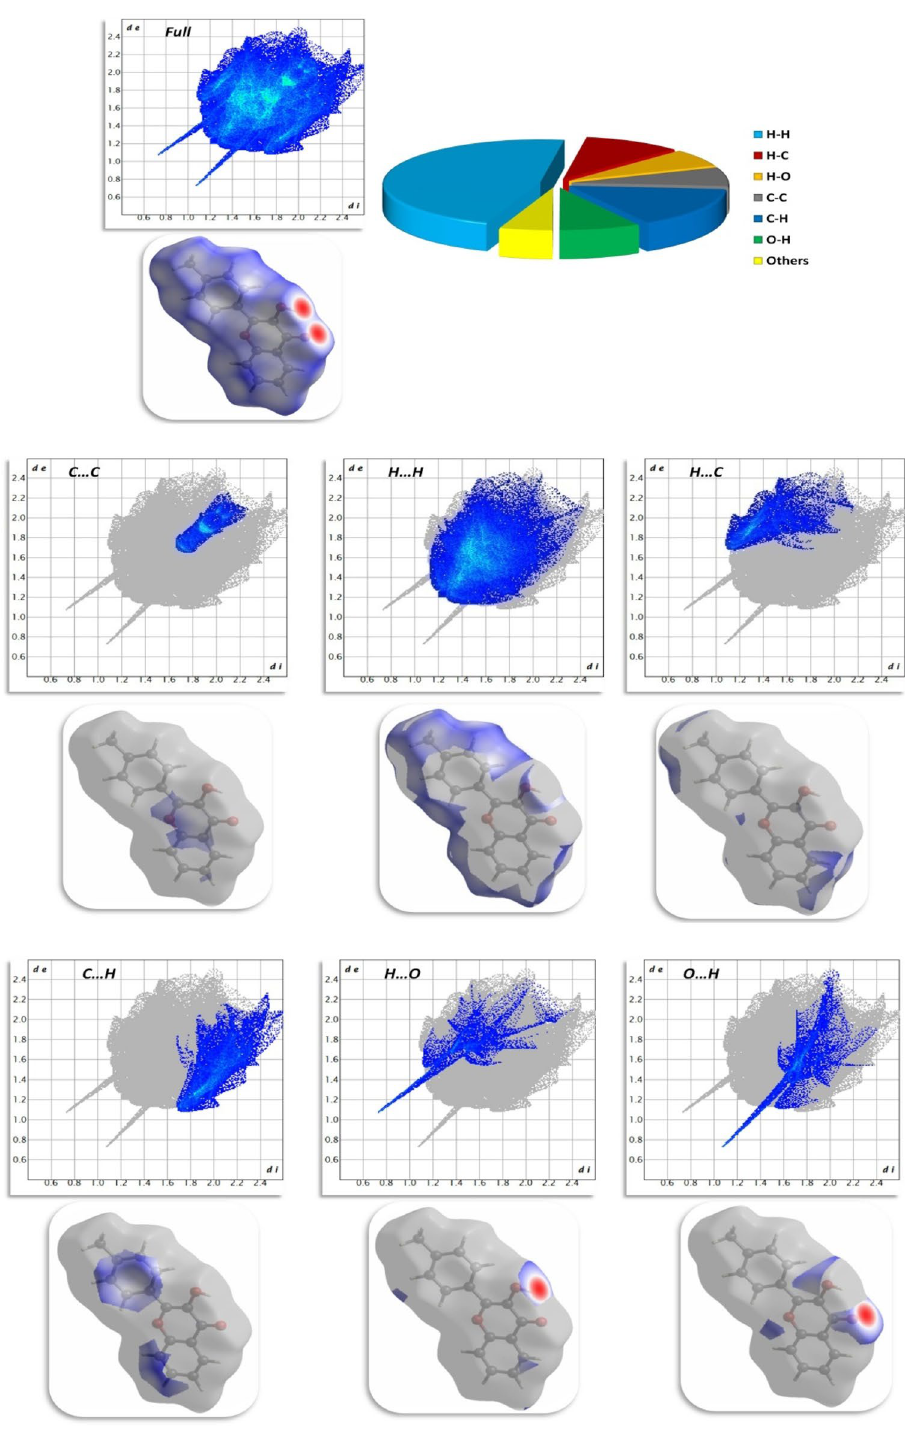
Figure 14. Selected fingerprint plots and d norm surfaces for important interactions in compound 12